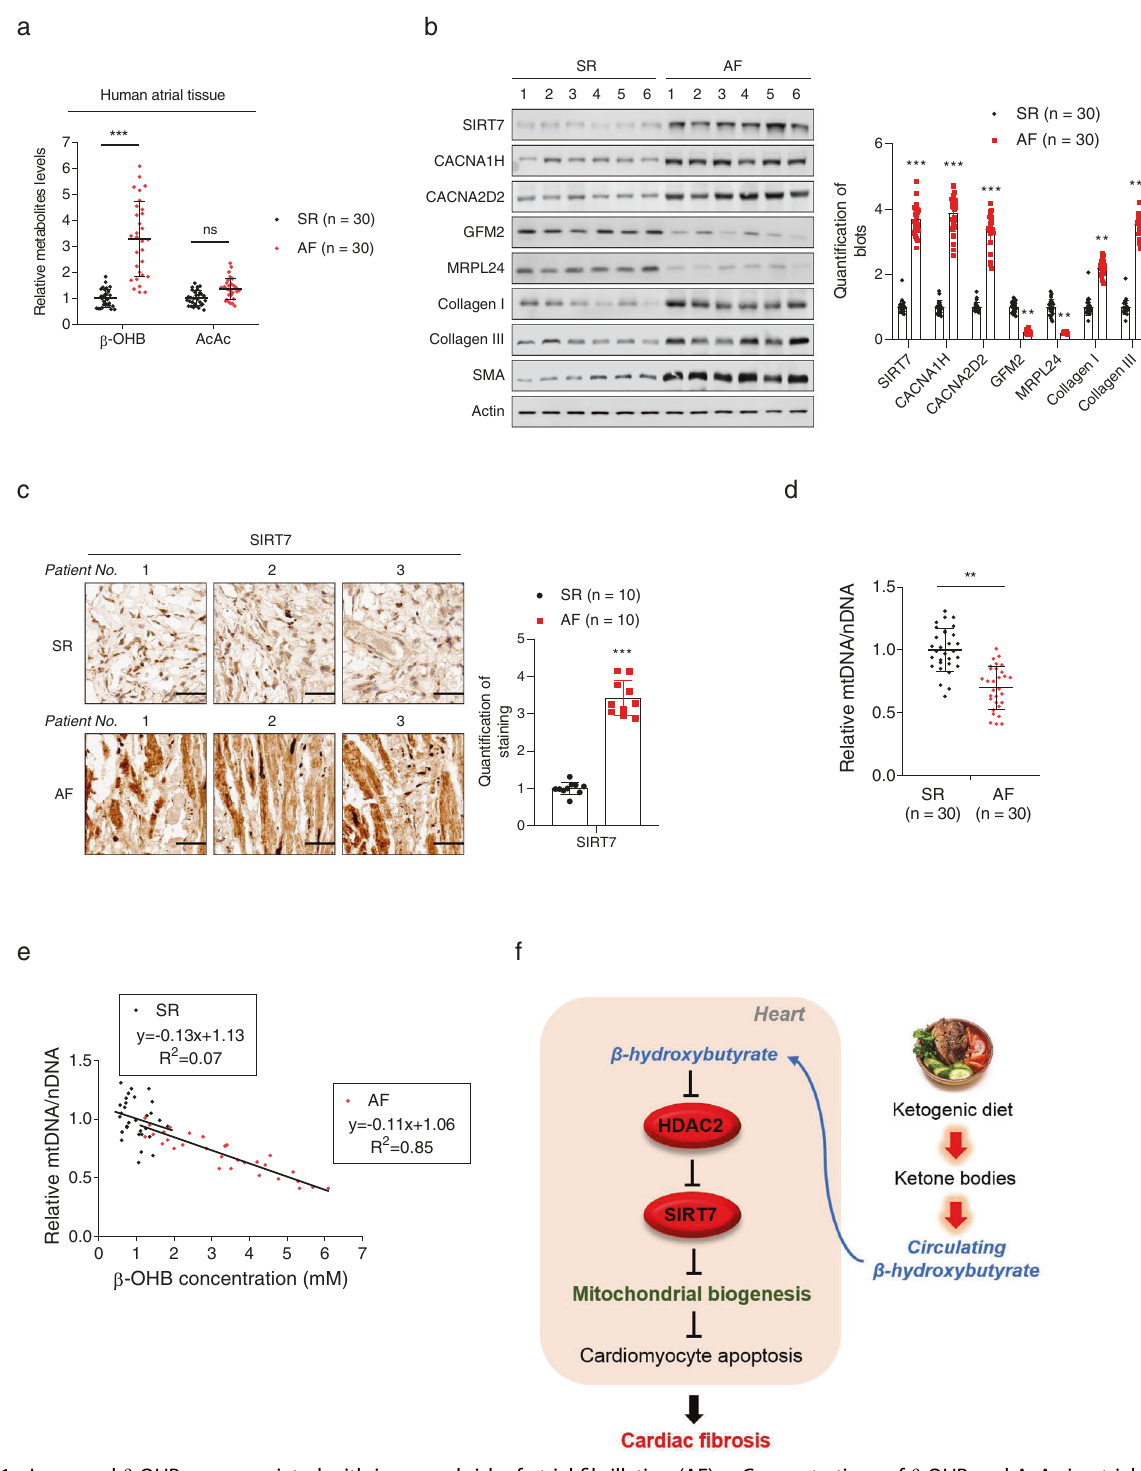
Fig. 6 Increased β -OHB was associated with increased risk of atrial fi brillation (AF). a Concentrations of β -OHB and AcAc in atrial tissues from patients with sinus rhythm (SR) and AF. b The left panel shows representative western blotting analysis of SIRT7, CACNA1H, CACNA2D2, GFM2, MRPL24, collagen I, collagen III, and α -SMA in atrial tissues from patients with SR and AF. The right panel shows the quantitative results. c IHC analysis of SIRT7 in atrial tissues from patients with SR and AF. The right panel shows the quantitative results. d Mitochondrial mass determined by mtDNA quanti fi cation in atrial tissues from patients with SR and AF. e Correlation between β -OHB concentration and mitochondrial mass in atrial tissues from patients with SR and AF. f Schematic illustration showing how KD increases the risk of cardiac fi brosis. Data shown are means ± standard errors. ns p > 0.05, * p < 0.05, ** p < 0.01, *** p < 0.001 versus the corresponding control group according to Student ’ s t tests. Some full-length blots are presented in the Supplementary Fig.